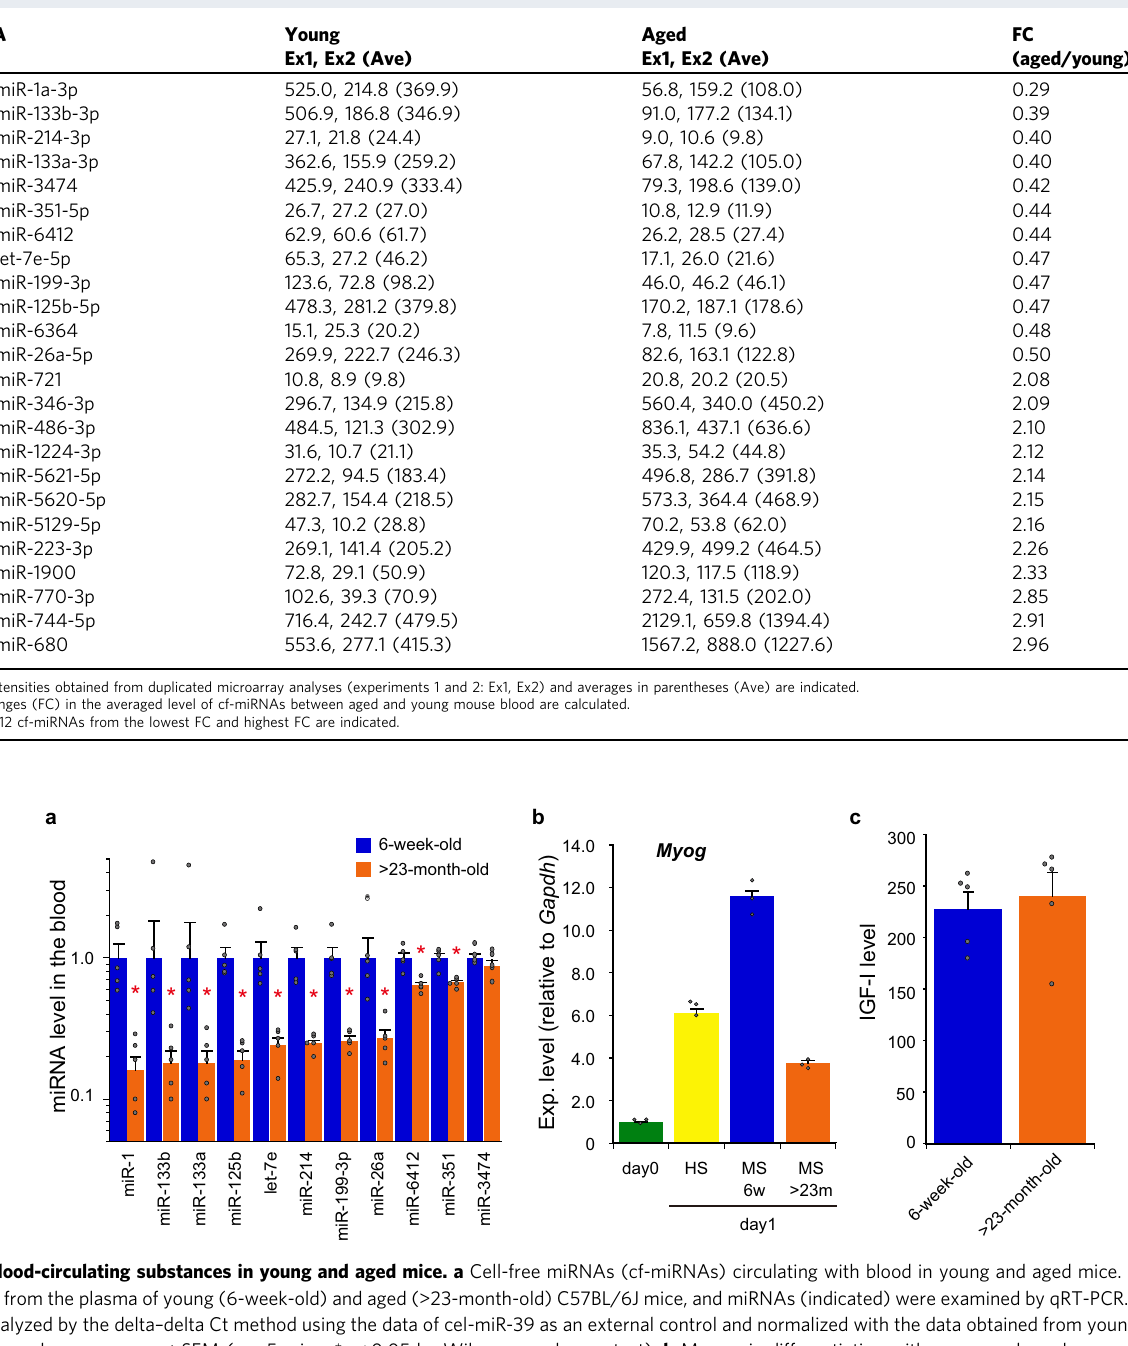
Table 1 Difference in the level of cf-miRNAs between young and aged mouse blood. miRNA